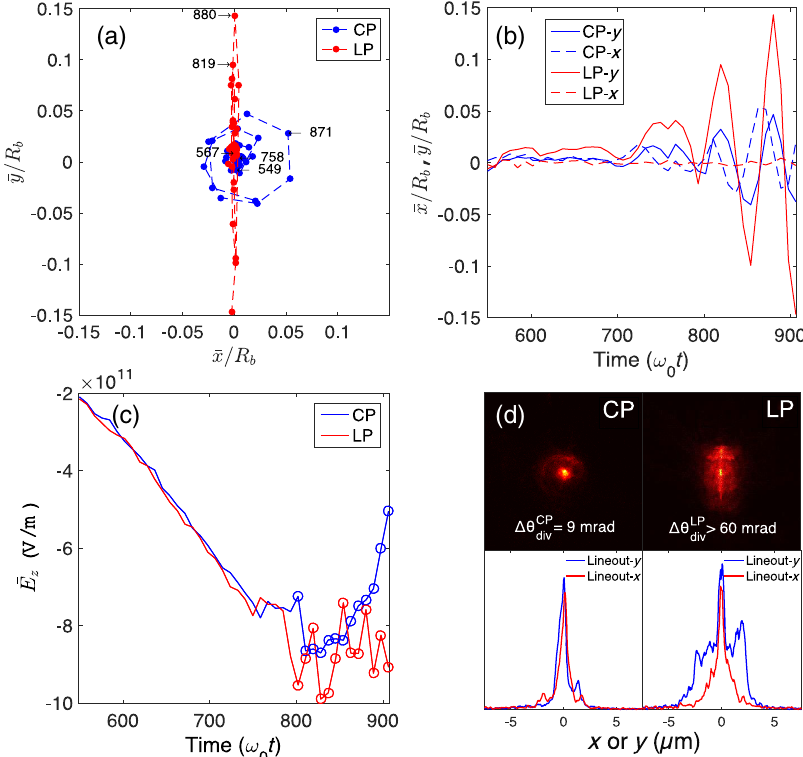
FIG. 5. Simulation parameters: LP or CP, 2.7 mJ, 5 fs, λ 0 ¼ 650 nm, vacuum spot FWHM 4 . 5 μ m, jet 140 μ m FWHM, 0 . 11 , and center of neutral hydrogen jet placed at the beam waist ( z 0 ). (a) Normalized bubble centroid position N =N e cr ¼ jet ¼ ð ¯ x=R b ; ¯ y=R b Þ in transverse plane v. time. CP ¼ circular polarization, LP ¼ linear polarization. Numbers near points are values of ω 0 t . 0 ; 0 ; ξ Þi (b) ¯ x=R and ¯ y=R vs time, showing the CEP slip-induced bubble centroid oscillations (see the text). (c) Average axial field h E b b z ð in the accelerating phase of the bubble vs time for CP and LP pulses. The open circles are for times after electron injection and before bubble breakup. (d) Top: electron beam profiles ( > 2 MeV) at ω 0 t ¼ 2000 from CP and LP pulses, where the bunch is near z ¼ 80 μ m. Δ θ 2 Δ θ 2 = 2 (cid:4) 1 = 2 is shown in the panels. Bottom: beam lineouts along x and y . The LP direction The rms beam divergence Δ θ x þ y Þ div ¼ ½ð is y